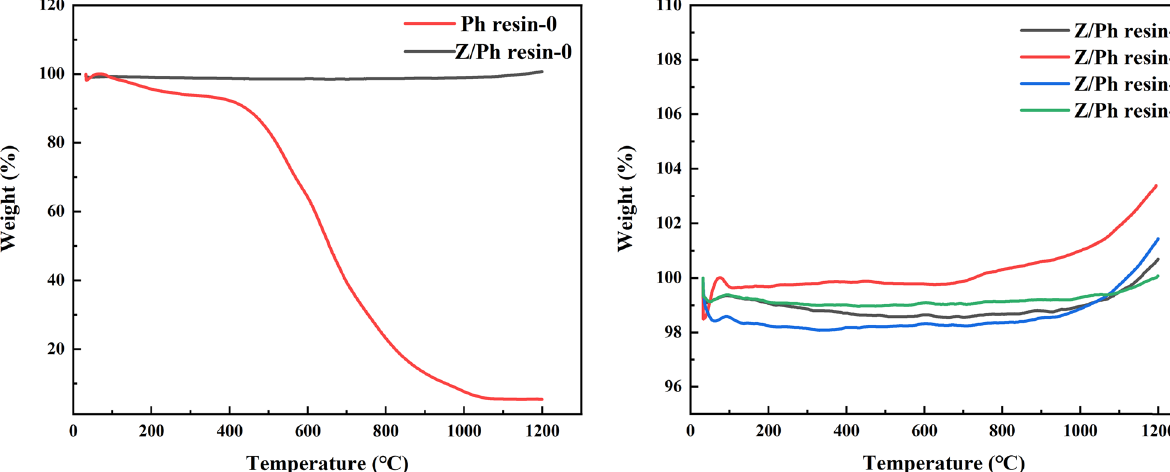
Figure 4: TG curves of Ph resin and Z/Ph resin. Figure 5: TG curves of Z/Ph resins after di ff erent heating